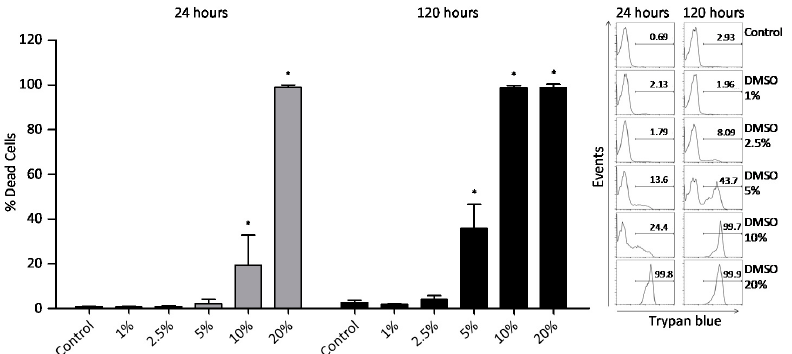
Figure 2. Dimethyl sulfoxide (DMSO) cytotoxic effect on peripheral blood mononuclear cells (PBMC) cultures at 24 and 120 h. Non-viable PBMC percentage ( n = 6 subjects) in cell cultures not treated with DMSO (control) or treated with it at concentrations of 1, 2.5, 5, 10, and 20% v/v . Results from trypan